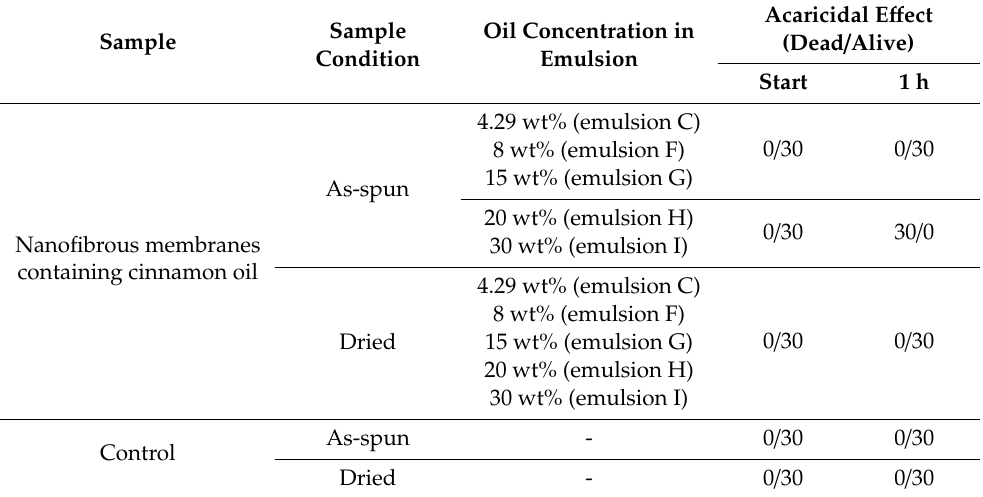
Table 4. Acaricidal e ff ects of nanofibrous membranes containing cinnamon oil against house dust mites at various oil